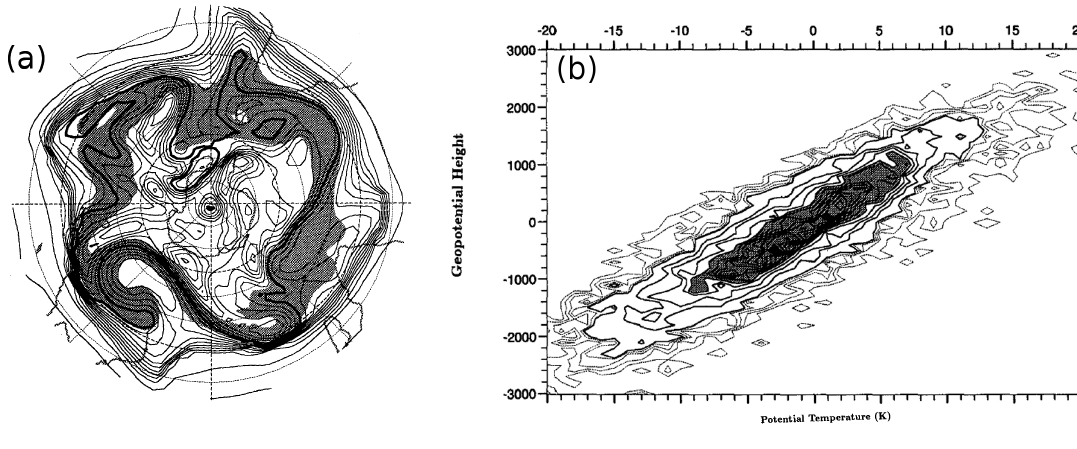
Figure 5. Validation of the SQG balance at the tropopause. ( a ) Geopotential height contours of the Potential Vorticity ( PV ) = − 2 surface (500-m intervals, heavy contour 10 km). The shading is the region where potential temperature lies between 310 and 330 K. Simulations taken from a General Circulation Model. ( b ) Contoured scatterplot of potential temperature anomalies (from zonal mean) versus geopotential height anomalies on the tropopause ( PV = − 2 PV units). In panel (a), there is a clear correspondence between geopotential height contours and potential temperature shadings. In panel (b), we clearly see the linearity between geopotential height and potential temperature at the tropopause. From [127]. c (cid:13) American Meteorological Society. Used with